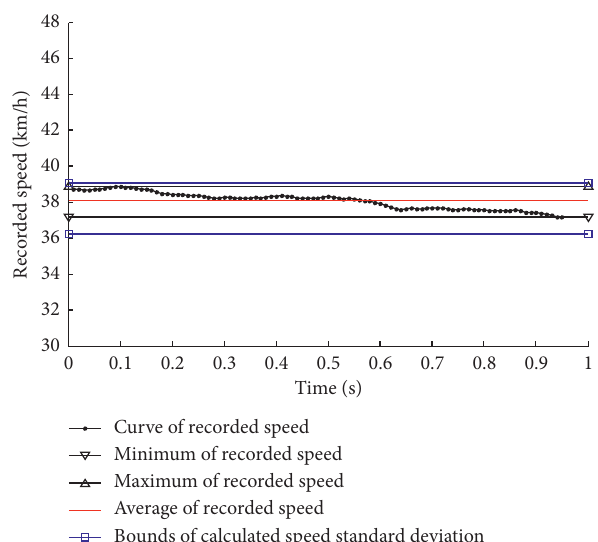
Figure 8: Compared analysis between v